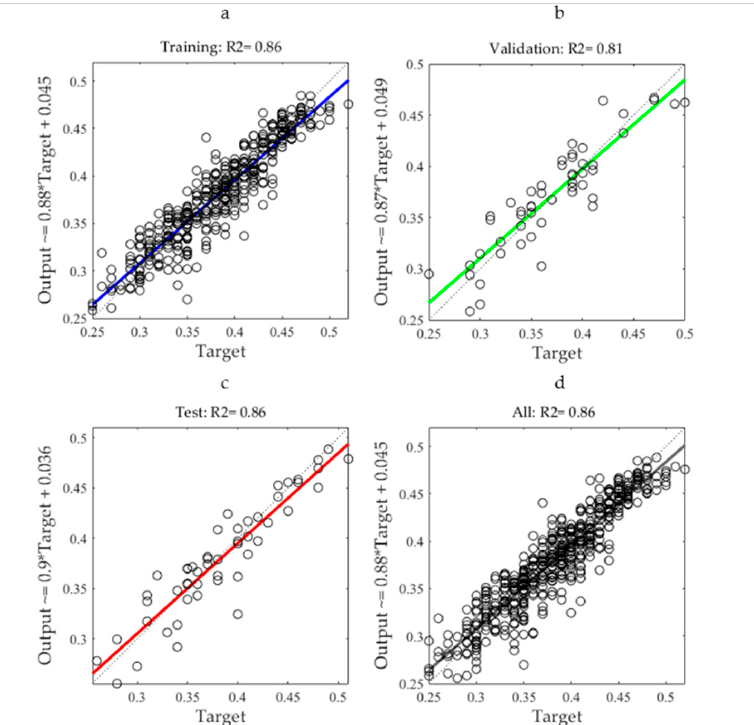
Figure 6. Linear regression between fruit acidity target values and those estimated through ANN model. Each subfigure represents the dataset of training ( a ), validation ( b ), test ( c ), and the whole dataset ( d ).